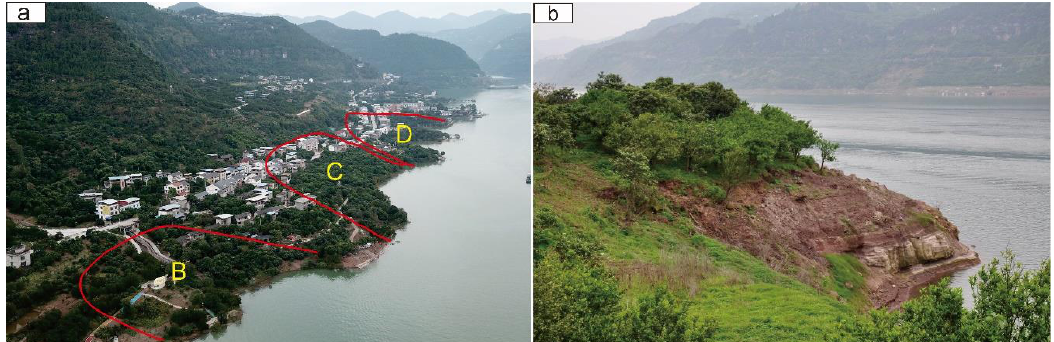
Figure 8. Photos of the Dazhou landslide: ( a ) Aerial photograph of the Dazhou landslide. ( b ) Shear crack at the front edge of the Dazhou landslide.